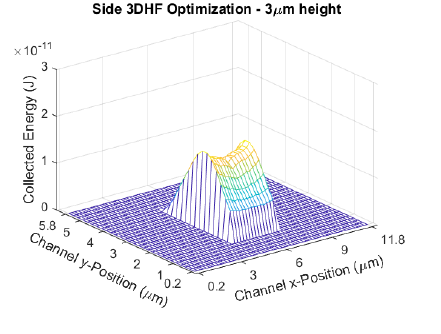
Table 4. Results of hydrodynamically-focused cross-section height optimization. Cross-Section Height